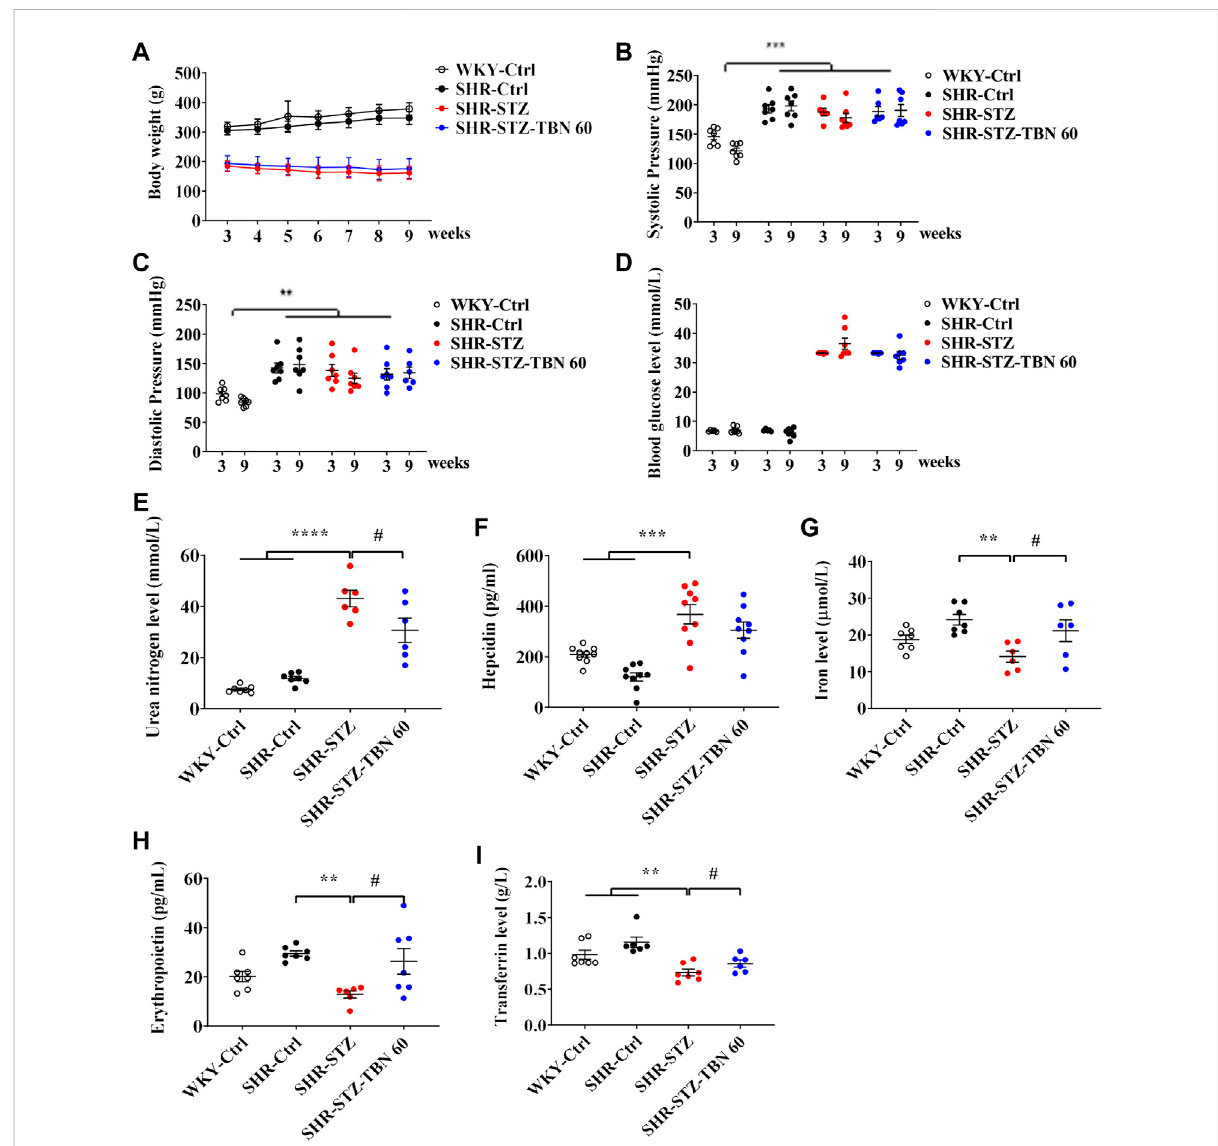
Effects of TBN on STZ-induced diabetic SHR rats. 11-week-old SHR rats are injected with a single dose of STZ (55 mg/kg) to induce diabetes. Shown are the effects of STZ and TBN on (A) body weight; (B,C) systolic pressure and diastolic pressure; (D) blood glucose level; (E) urea nitrogen level in diabetic-SHR rats treated with TBN. The changes of (F) hepcidin, (G) iron level, (H) EPO, and (I) Tf level in the serum of SHR rats after TBN treatment( n =6 – 9foreachgroup).Dataarepresentedasmean±SEM; ** p < 0.01; *** p < 0.001; **** p <